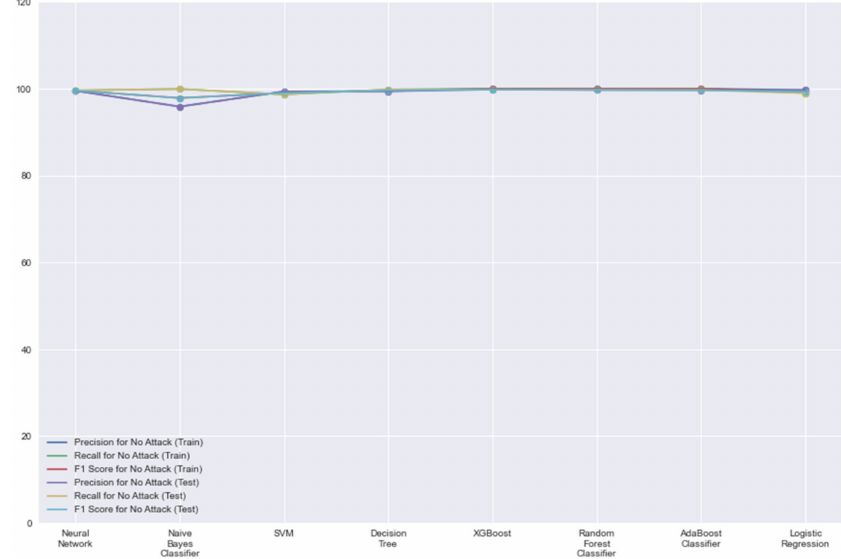
Figure 5. Classification report for ‘No Attack’ label.